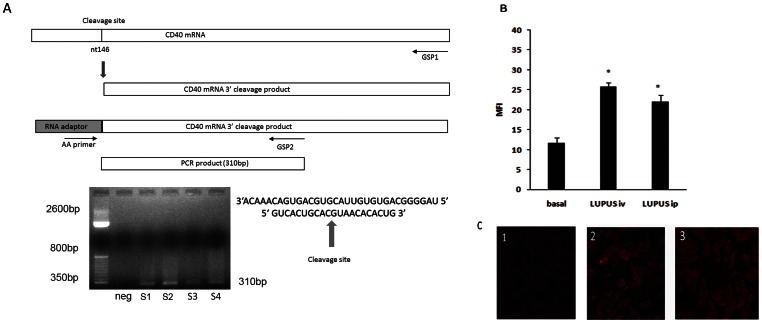
siRNA-mediated cleavage of CD40 mRNA in vivo. Confocal fluorescence and brightfield images of siRNA internalization in DC.A) Schematic representation of the CD40 mRNA illustrating siRNA cleavage sites and RACE strategy to detect cleavage product. Agarose gel of RACE–PCR amplification showing specific cleavage products in different lupus nephritis samples (S1 and S2), and in vitro DC culture (S3 and S4). B) Quantification of renal internalization of Chol-siRNA administered iv/ip in lupus mice. C) Representative kidney photomicrographs (x400) of 1- Basal auto fluorescence, 2- iv administration, 3- ip administration. Data are expressed as mean±SEM of four separate experiments.*p<0.05 vs basal.